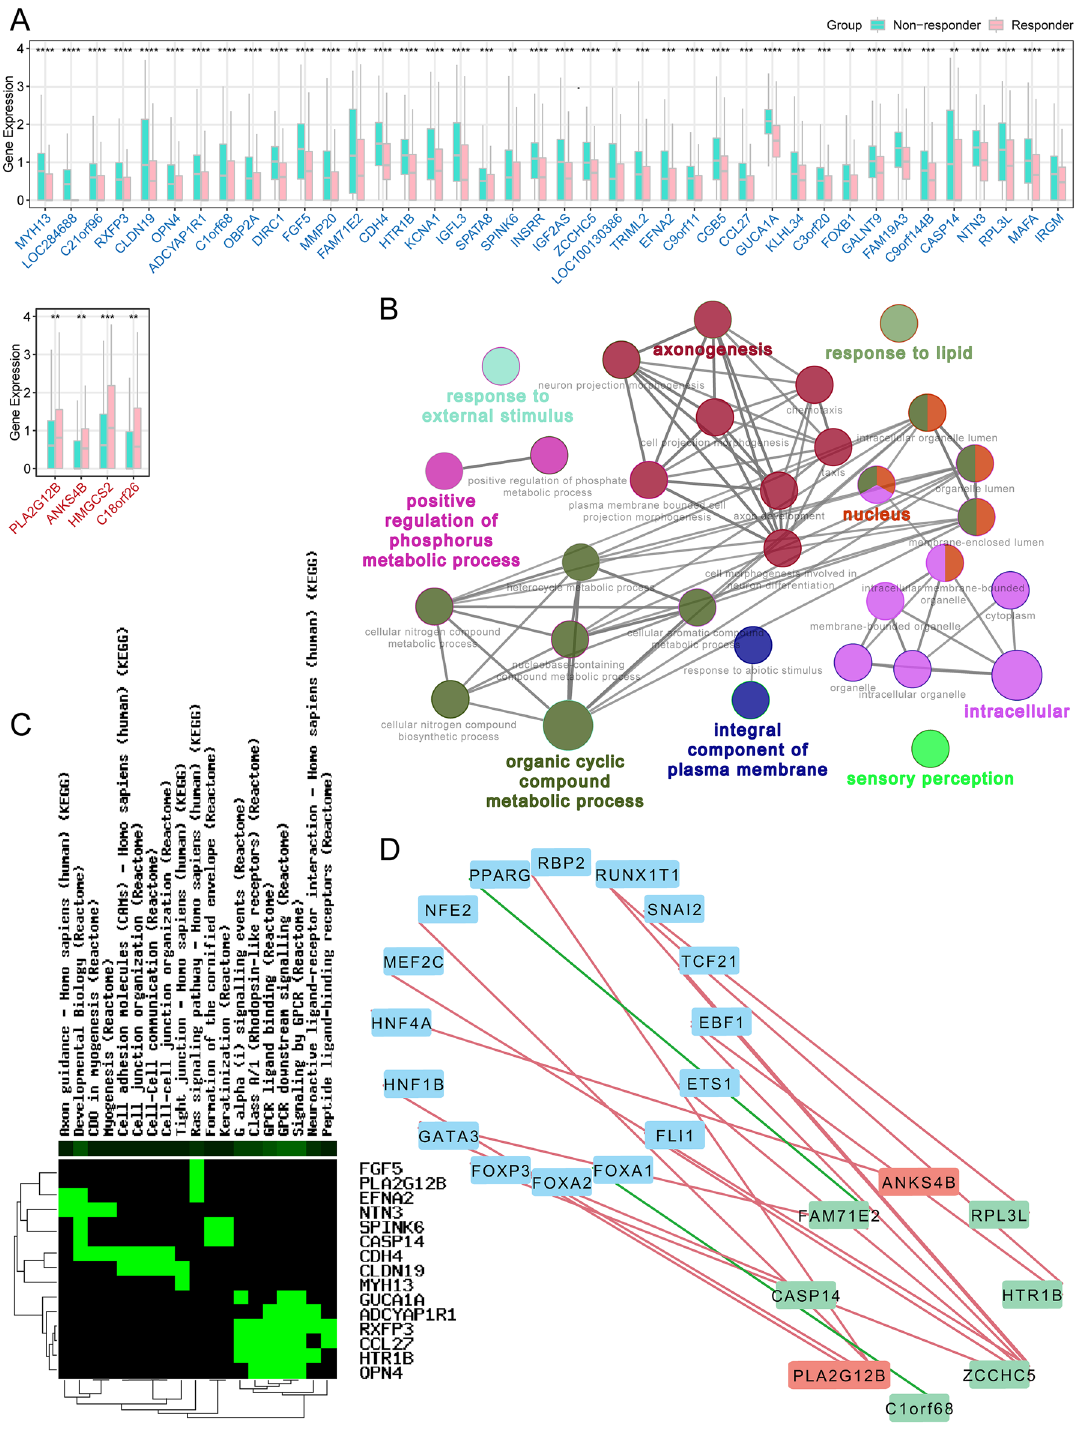
Figure 3. GO and KEGG enrichment analysis ( A ) Boxplot showed the 44 DEGs between responder and non- responder groups. ( B ) Go analysis of the 44 DEGs. ( C ) KEGG pathway analysis of the DEGs. ( D ) Regulatory network of TFs-DEGs. The DEGs in red showed high expression, and green showed low expression. The red line showed a positive correlation, and the green line showed a negative